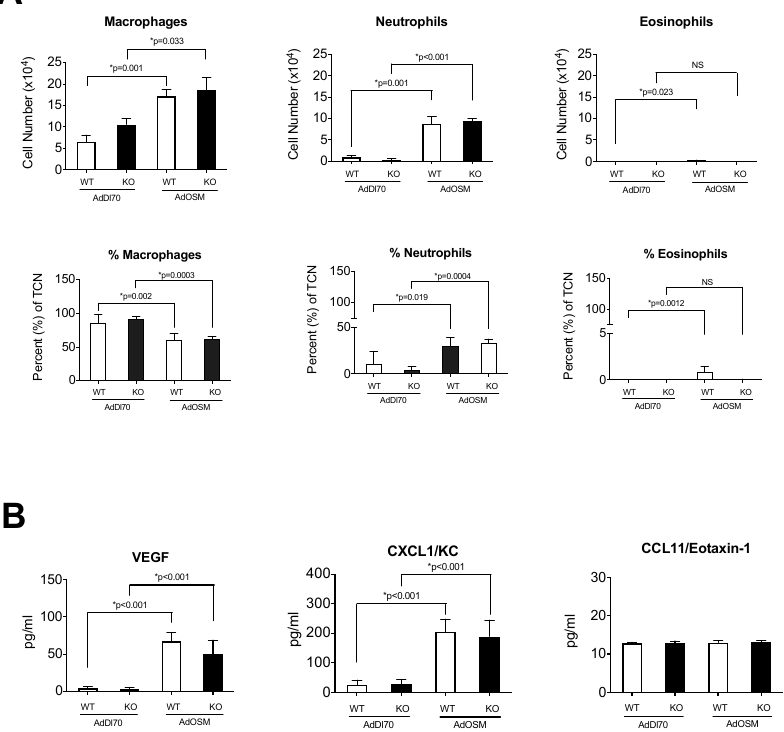
Figure 2. Inflammatory cells and cytokines in BALF at Day 7 in Response to AdOSM. ( A ) Wildtype (WT) and IL-13-/- (KO) BALB/c mice were treated with an endotracheal administration of AdDl70 or AdOSM (5 × 10 7 pfu), culled at day 7, and bronchoalveolar lavage fluid (BALF) was collected and analyzed for cell numbers and percent of total cell number (TCN) of macrophages, neutrophils, and eosinophils in stained cytocentrifuge smears. ( B ) IL-6, CXCL1/KC and CCL11/Eotaxin-1 cytokine levels in BALF used in ( A ) was measured by ELISA. White bars are wildtype and black bars are IL-13-/- data. Data is shown as the mean +/ − SEM ( n = 5 per group). Statistical significant differences are noted with their p values between the indicated treatment groups.